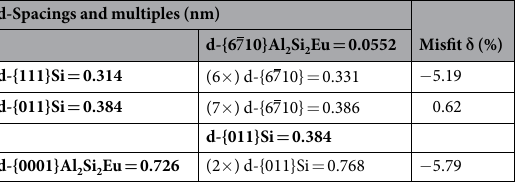
Table 1. Misfits of Al 2 Si 2 Eu related to Si for the parallel planes found in EBSD/TKD.